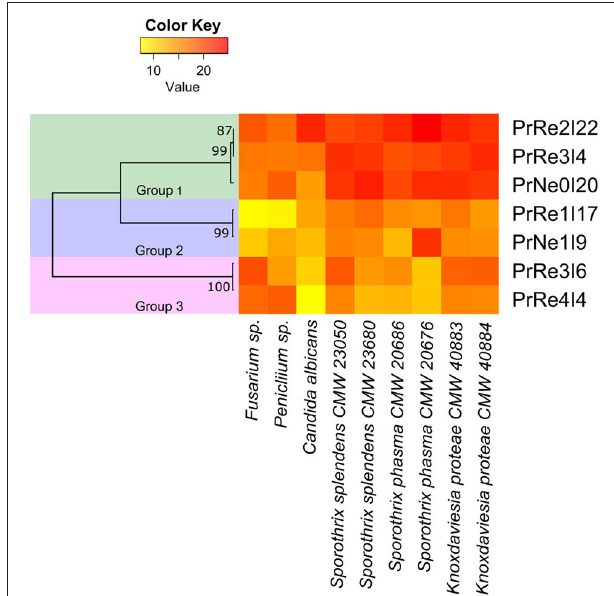
FIGURE 4 | Heatmap illustrating in vitro bioassay results. Values represented from 0 to 22.8 on a continuous scale from yellow to red. Phylogenetic relationships between bacterial isolates are presented to the left of the